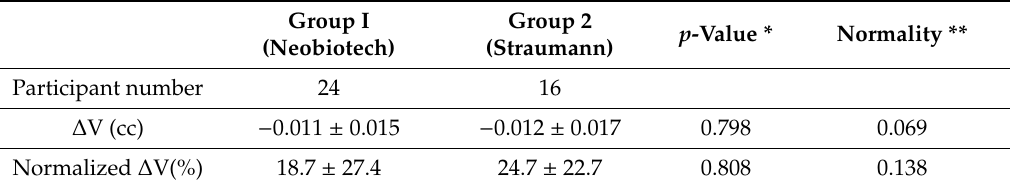
Figure 4. Measurement results of volumetric change of alveolar bone, ∆ V ( A ) and normalized ∆ V ( B ), after implant installation for 40 implants when height, h, was set to 3 mm. Table 1. Change of marginal bone loss after 1 year.